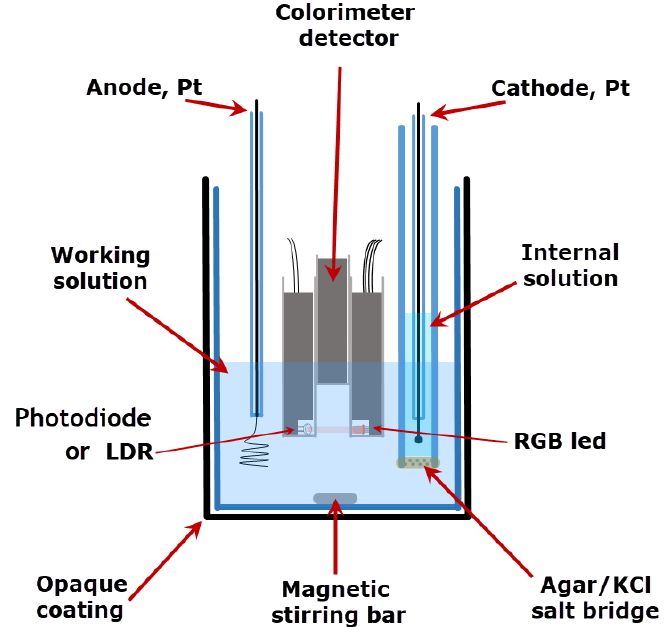
Figure 5. Schematics of the two-compartment coulometric cell employed for iodometric